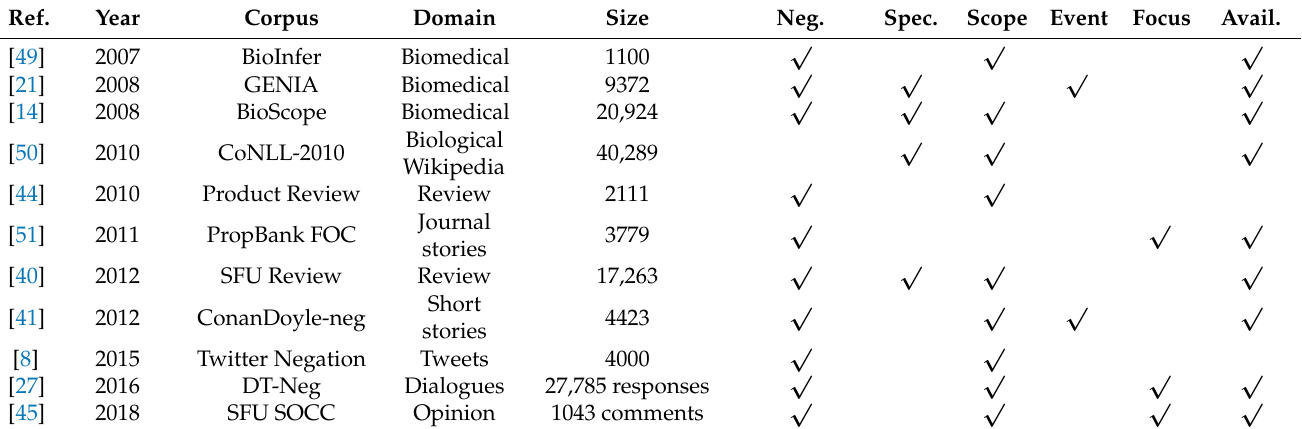
Table 1. English corpora annotated for negation and/or speculation.